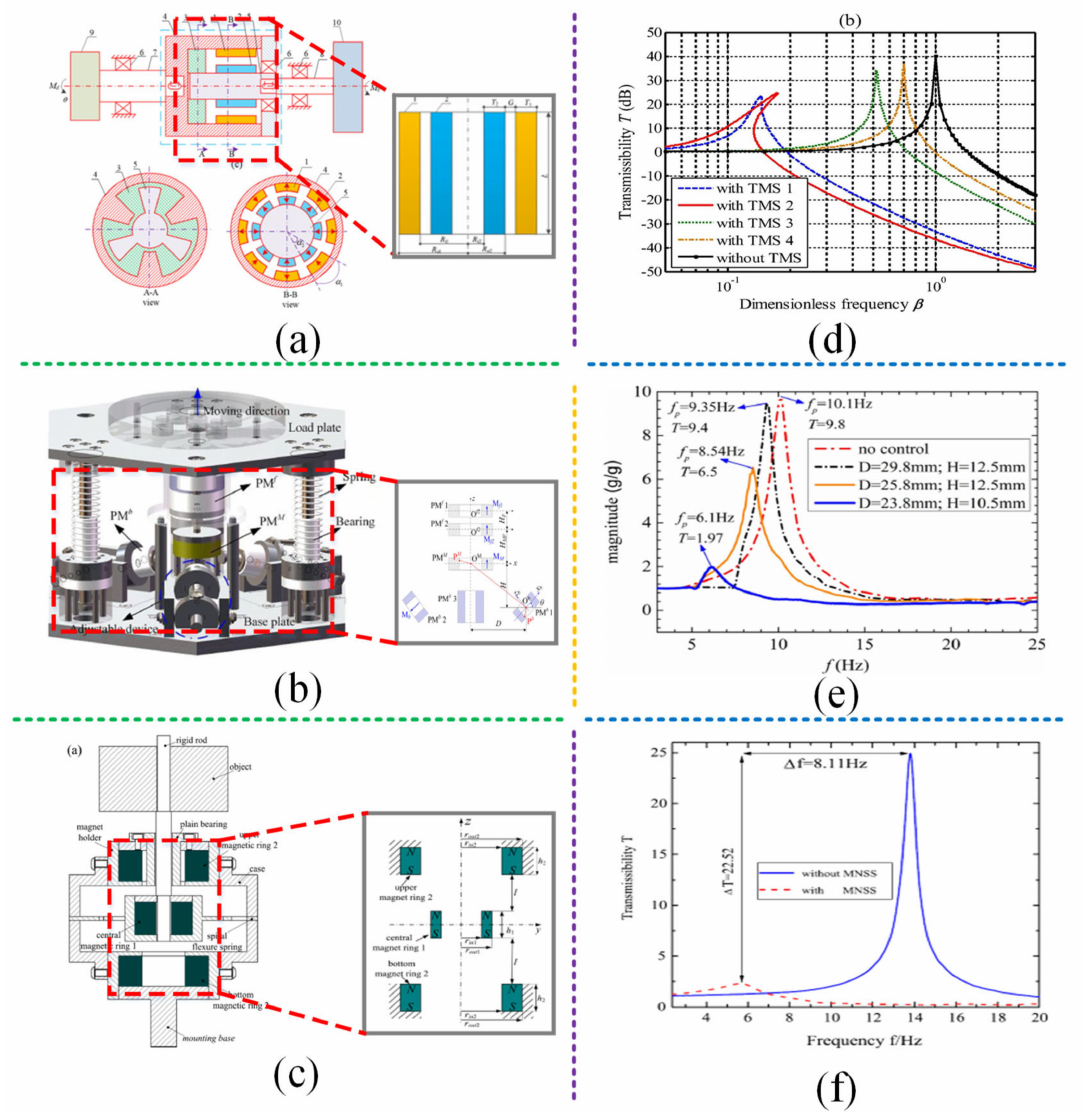
Figure 17. Annular permanent magnet structure: ( a ) The torsion magnetic spring structure with a pair of mutually repelling magnetic rings proposed by Zheng et al. [58]; figures adapted with permission from Ref. [58]. Copyright 2018, copyright Zheng, Y.; ( b ) The magnet structure composed of three moving ring permanent magnets and three fixed ones proposed by Yan et al. [67]; figures adapted with permission from Ref. [67]. Copyright 2018, copyright Yan, B.; ( c ) The magnet structure composed of three axially magnetized magnetic rings proposed by Dong et al. [70]; figures adapted with permission from Ref. [70]. Copyright 2017, copyright Dong, G.; ( d – f ) show the